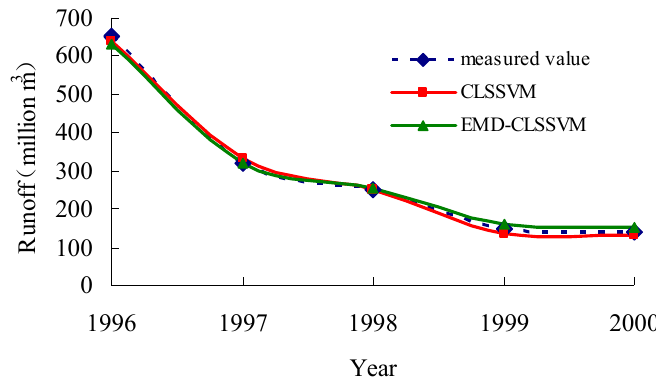
Figure 12. Prediction results of annual runoff for Fenhe reservoir station.